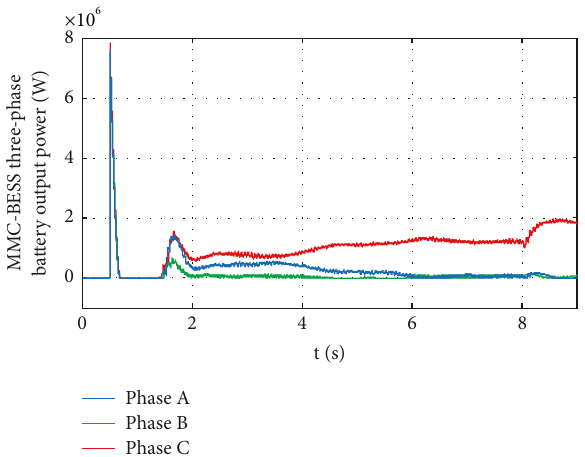
Figure 22: MMC-BESS three-phase battery output power.